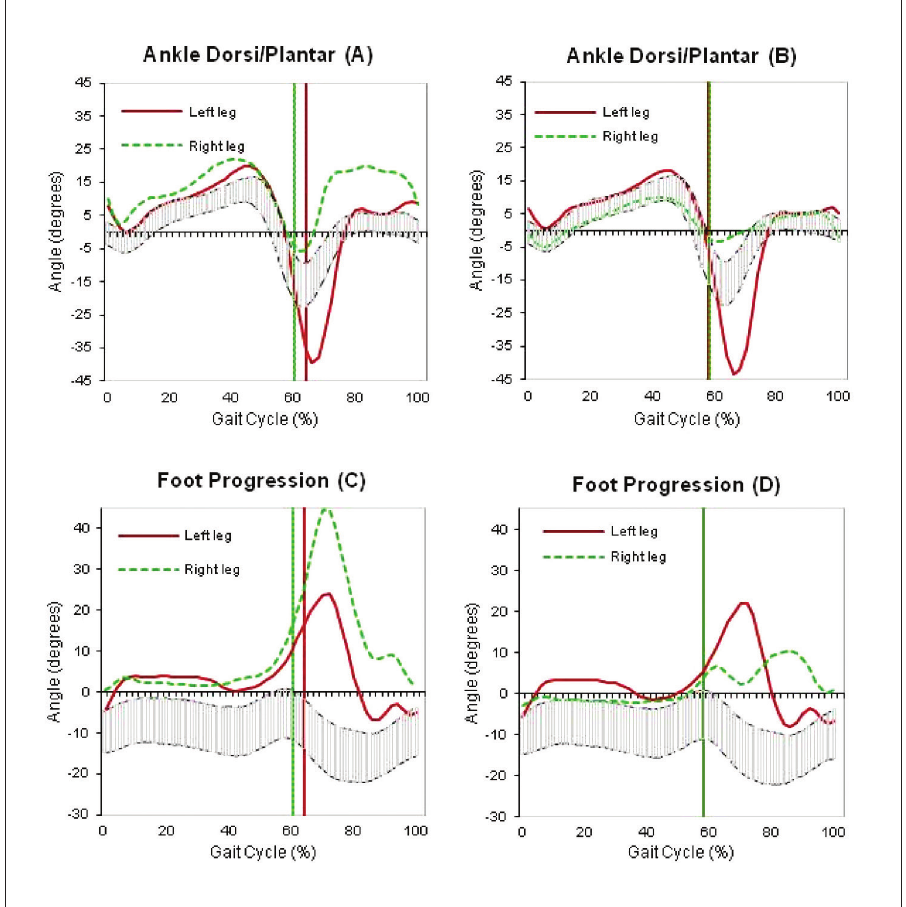
Table 2. Gait characteristics of ankle and knee joints with and without the orthosis in incomplete spinal cord injured patient Gait characteristic Ankle joint angles (˚) Dorsiflexion at initial contact 9.9 ± 2.7 –0.5 ± 1.1 Dorsiflexion at mid-stance 18.3 ±